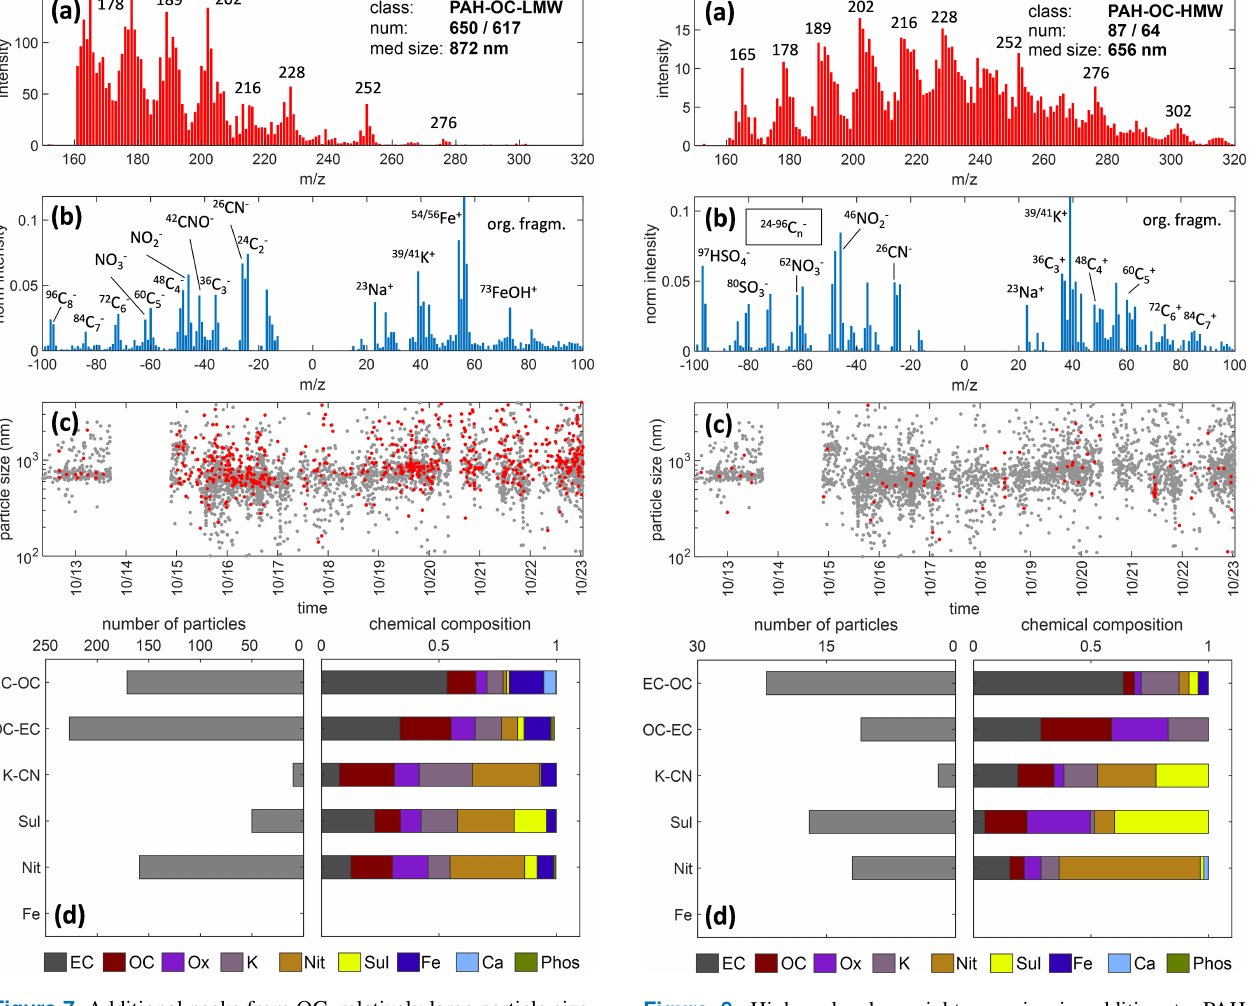
Figure 7. Additional peaks from OC, relatively large particle size, Figure 8. High-molecular-weight organics in addition to PAH and frequently detected 46 NO − and 62 NO − signals indicate the up- peaks are frequently associated with fragments from oxidized OC 2 3 take of secondary material. (For figure explanation, see Fig. 5.) (e.g., 43 C 2 H 3 O + ) and high sulfate signals. This supports the pro- moted secondary organic aerosol (SOA) formation and oligomer- ization in acidic particles. Note also the cluster with dominating HMW OC and high sulfate signals in Fig. S5. (For figure explana- tion, see Fig.